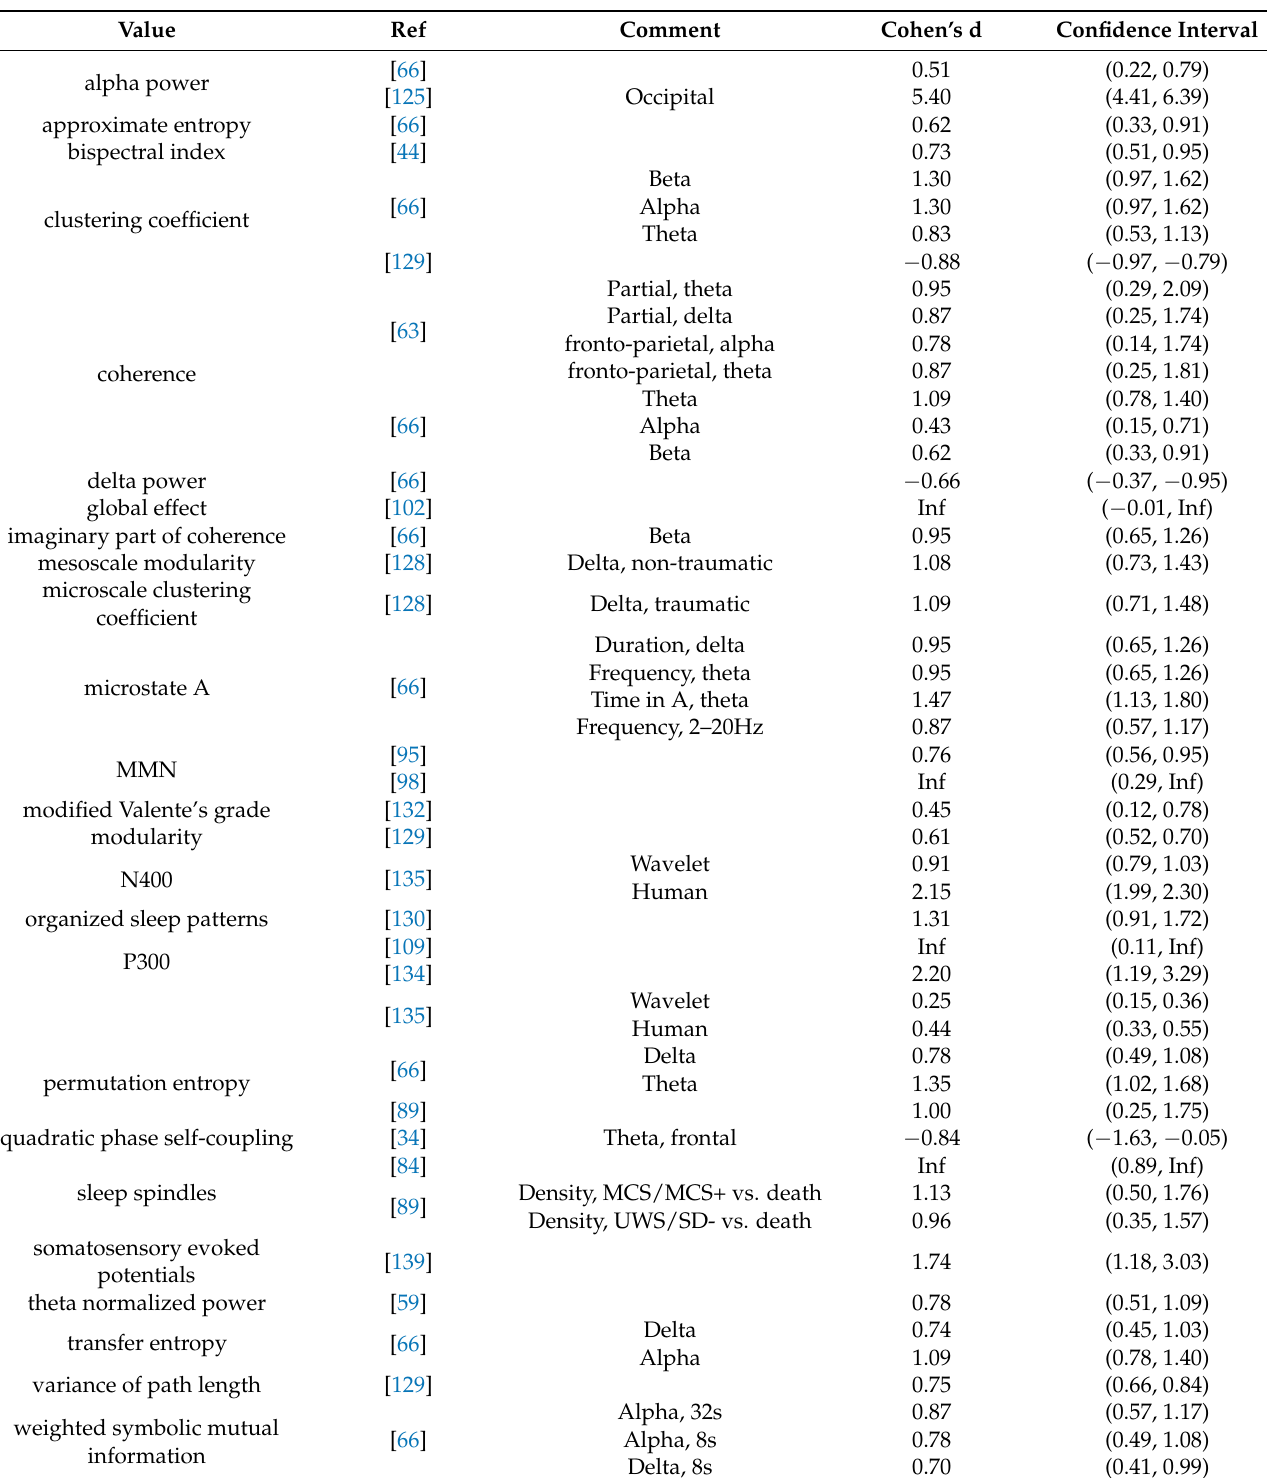
Table 8. Overview of different values and the correlation with better outcome; abbreviations can be found in Abbreviation. d is Cohen’s d and the values in parenthesis are the confidence intervals. Papers that do not present enough data to calculate Cohen’s d are not included in the